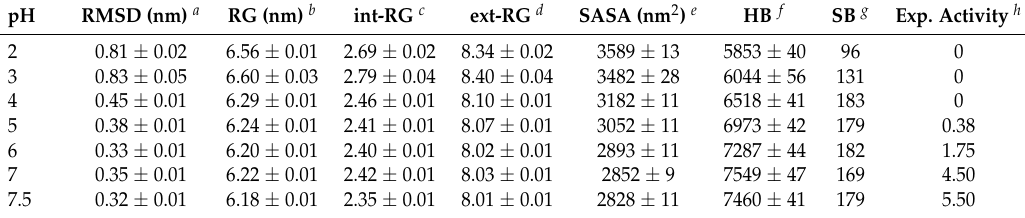
Table 3. Root-mean-square deviation (RMSD), radius of gyration (RG), solvent-accessible surface area (SASA), hydrogen bonds (HB) and salt bridges (SB) averaged over the last 20 ns or in the last frame of MD simulations at different